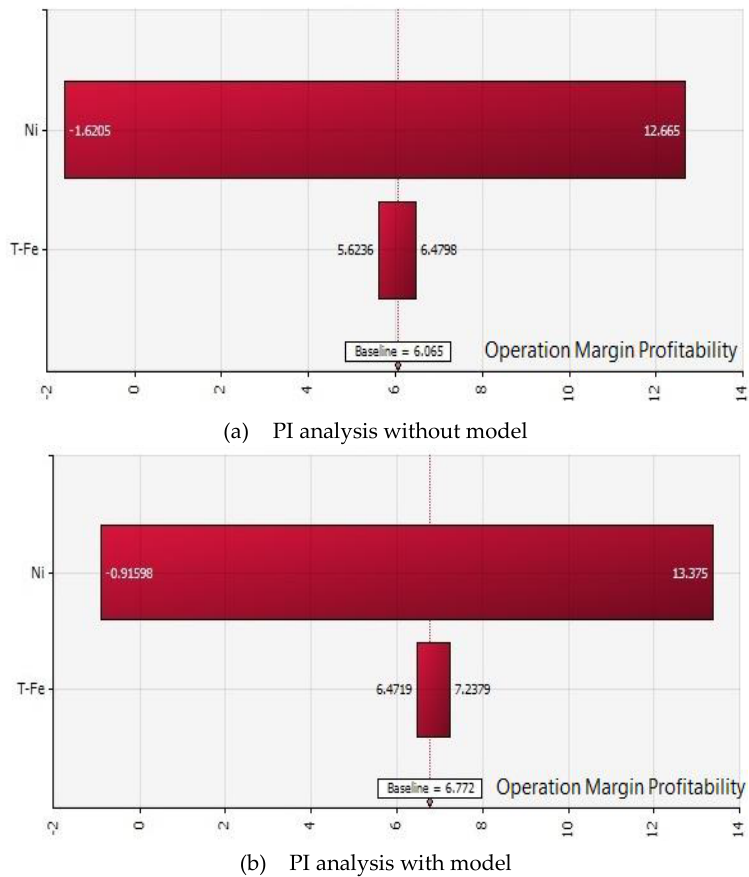
Figure 9. IRR probabilistic analysis (a) without model and (b) with model